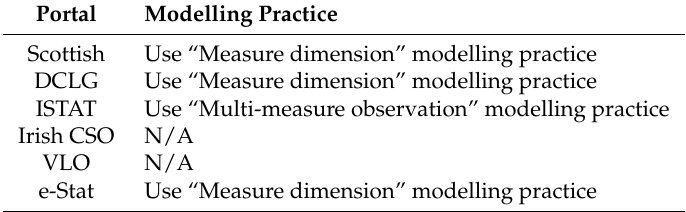
Table 28. Modelling practices of data portals for multiple measures in data cubes.